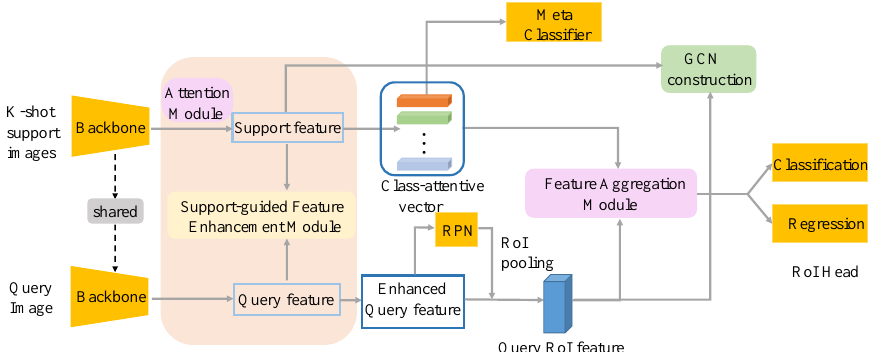
Figure 1. Architecture of the proposed RelationGCN for few-shot object detection on SAR images, which mainly consists of three components: a lightweight attention module to extract more relevant support information, a support-guided feature enhance module that injects different support images as guidance for better generation of higher-qualified object proposals, and a graph convolutional network which models the relationship between support features and query RoI features to further implicitly boost class